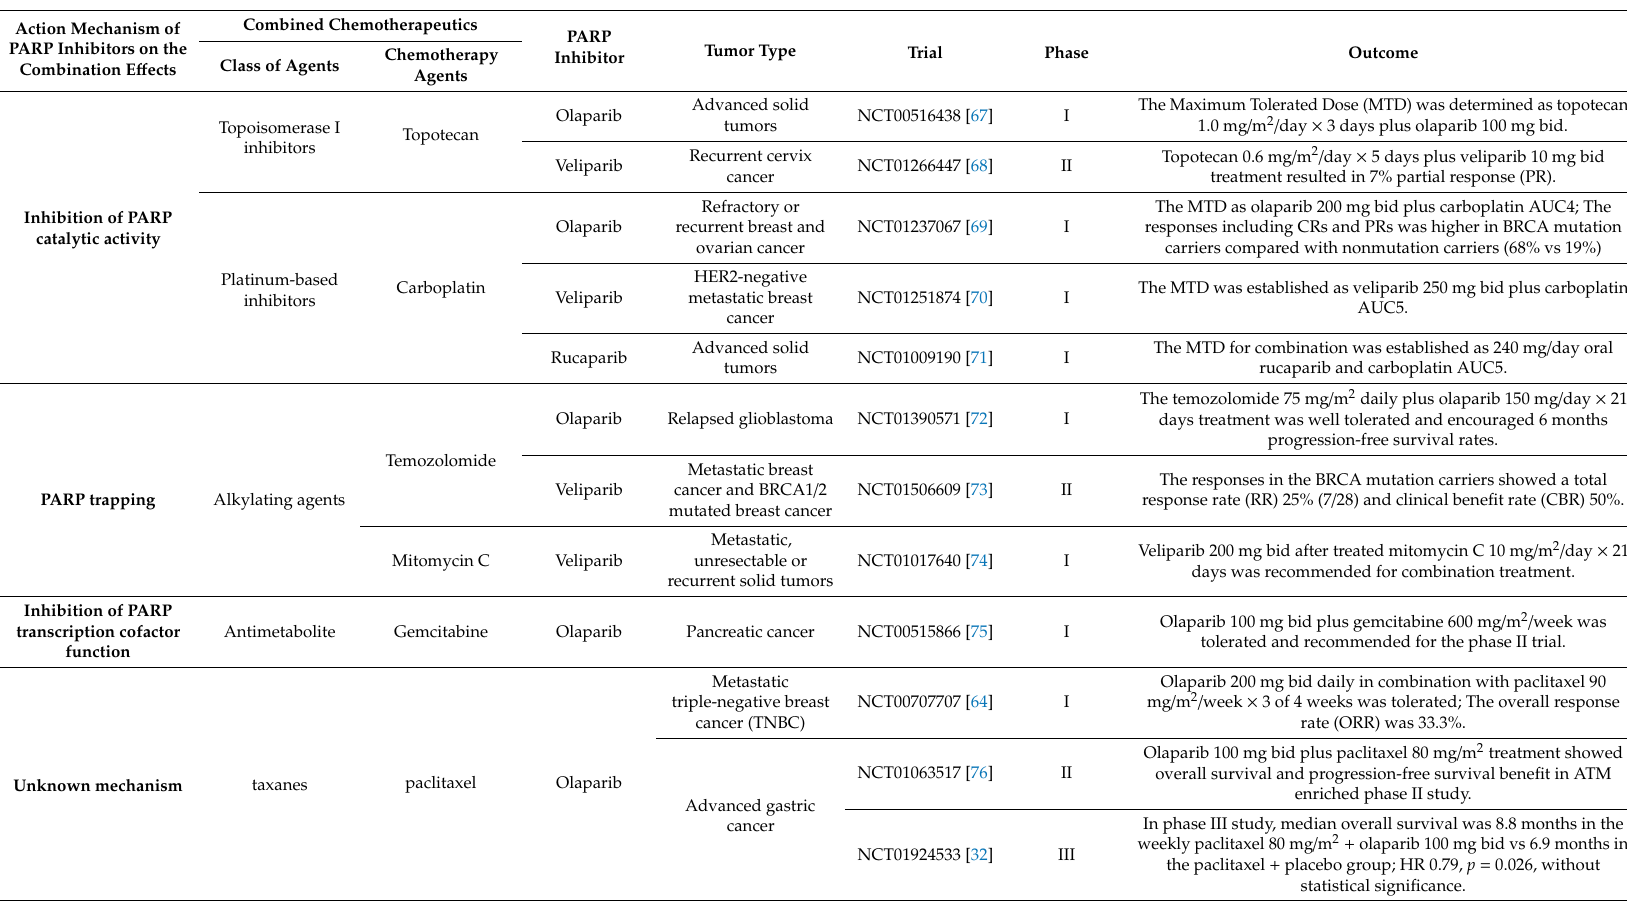
The table is based on the details from http: // www.clinicaltrials.gov /